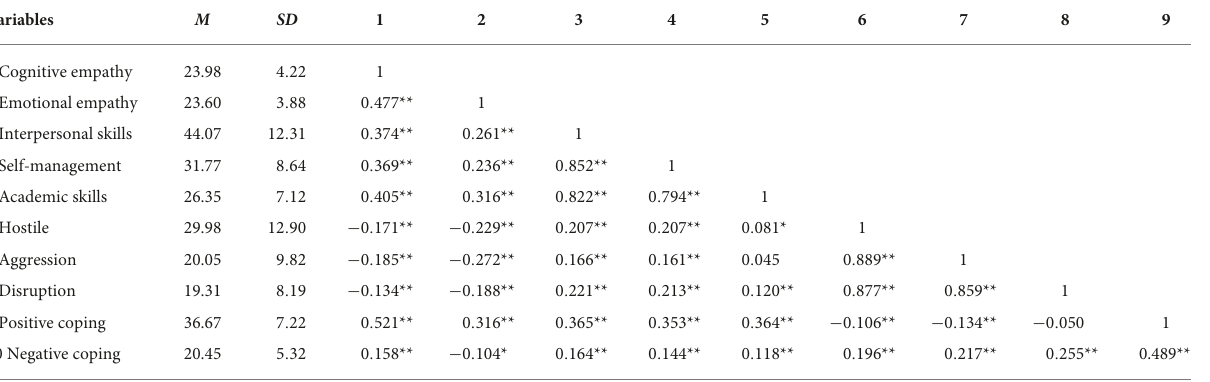
TABLE 1 Means, standard deviations of key variables and Pearson’s correlations between them ( N = 605).